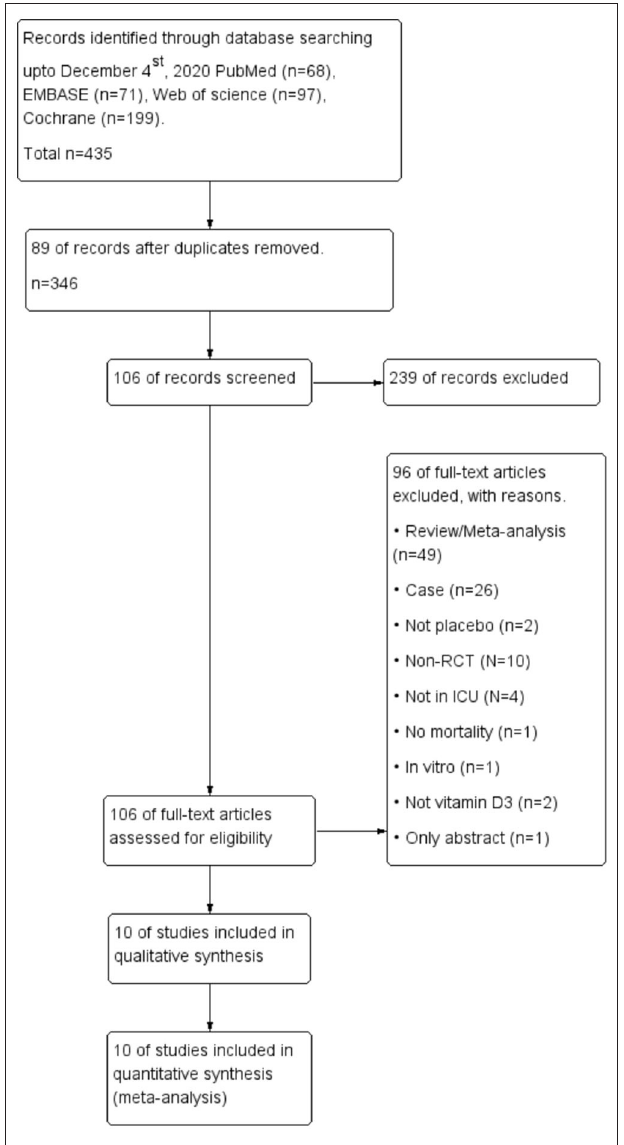
FIGURE 1 | Flow chart of the search process and study